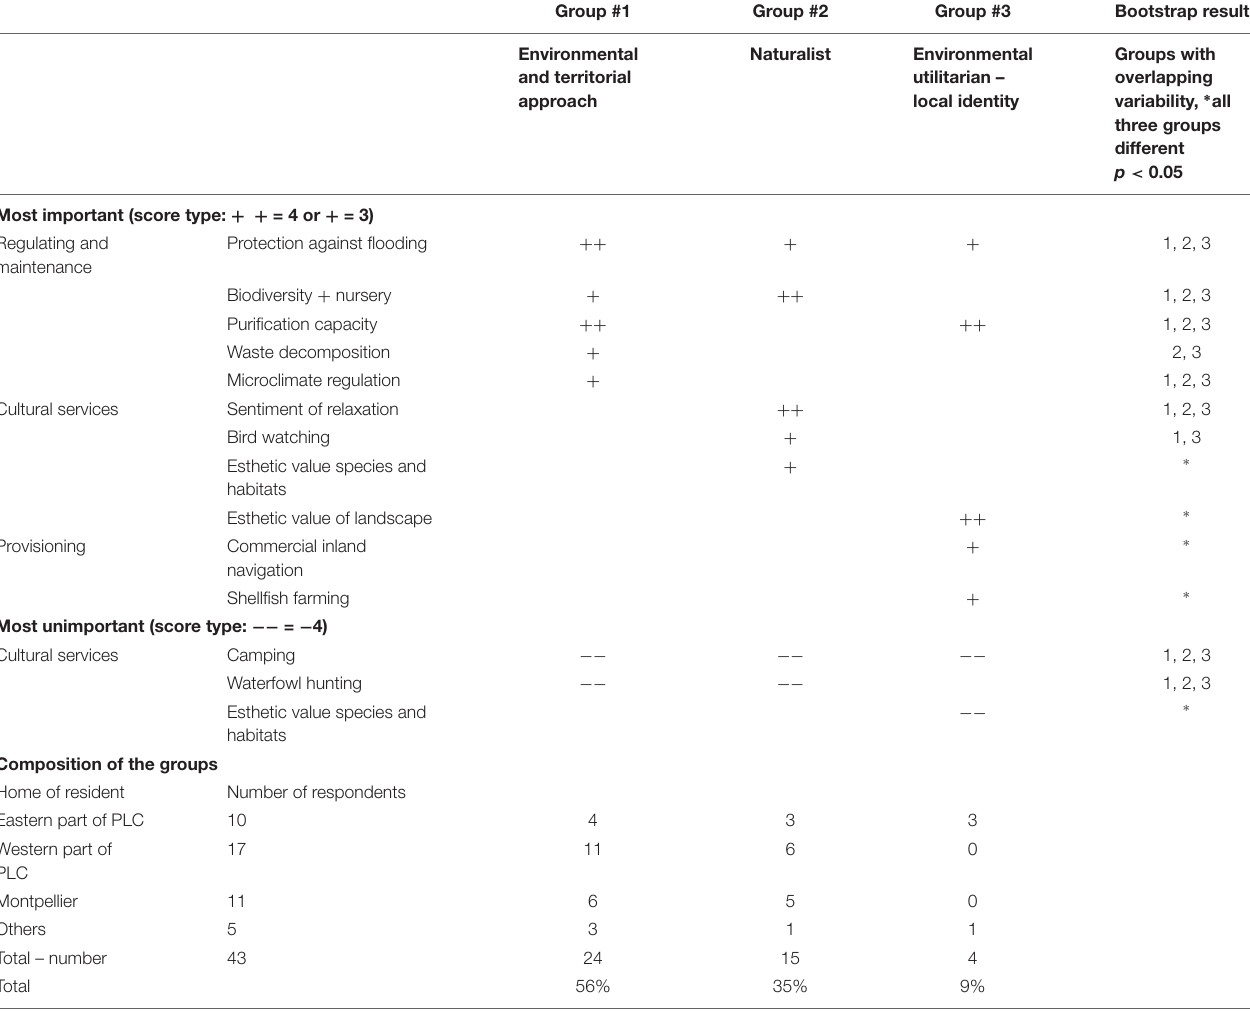
TABLE 3 | Most salient results from analyzing the Q-sorts of the 43 participants in citizen workshops.